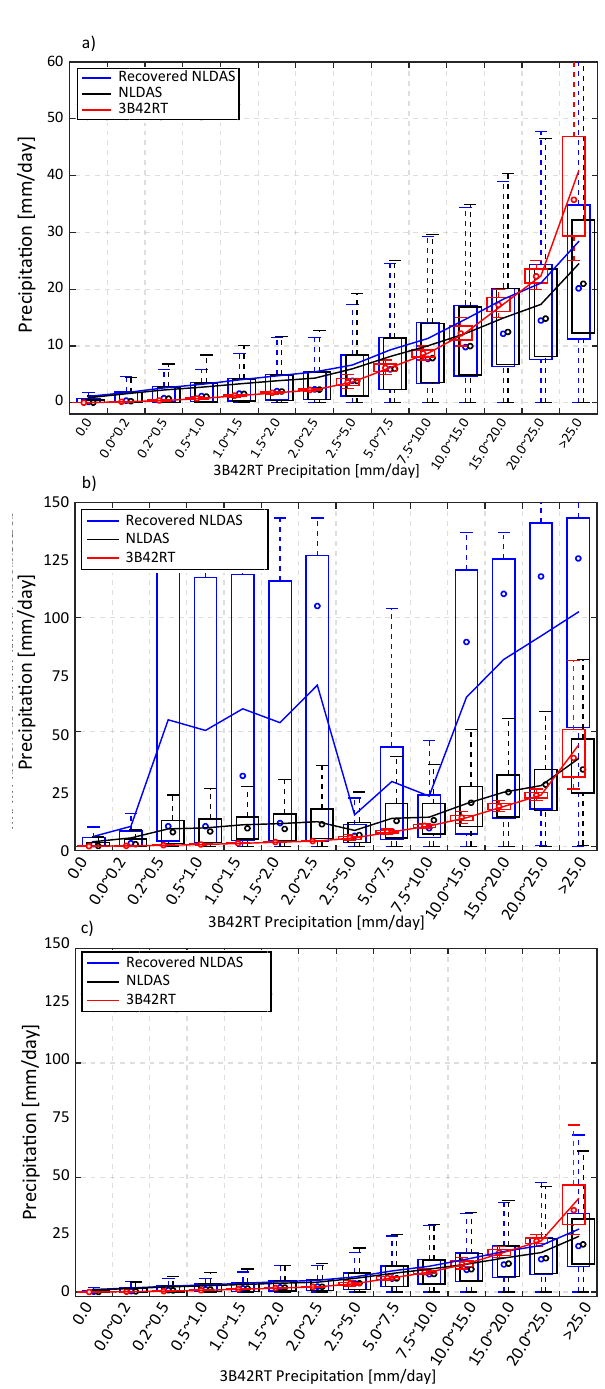
Figure 6. Accuracy of recovered precipitation in an idealized ex- periment: (a) overall performance and separately comparing the im- provement performance of recovered NLDAS precipitation (b) with and (c) without surface saturation condition. Statistics provided